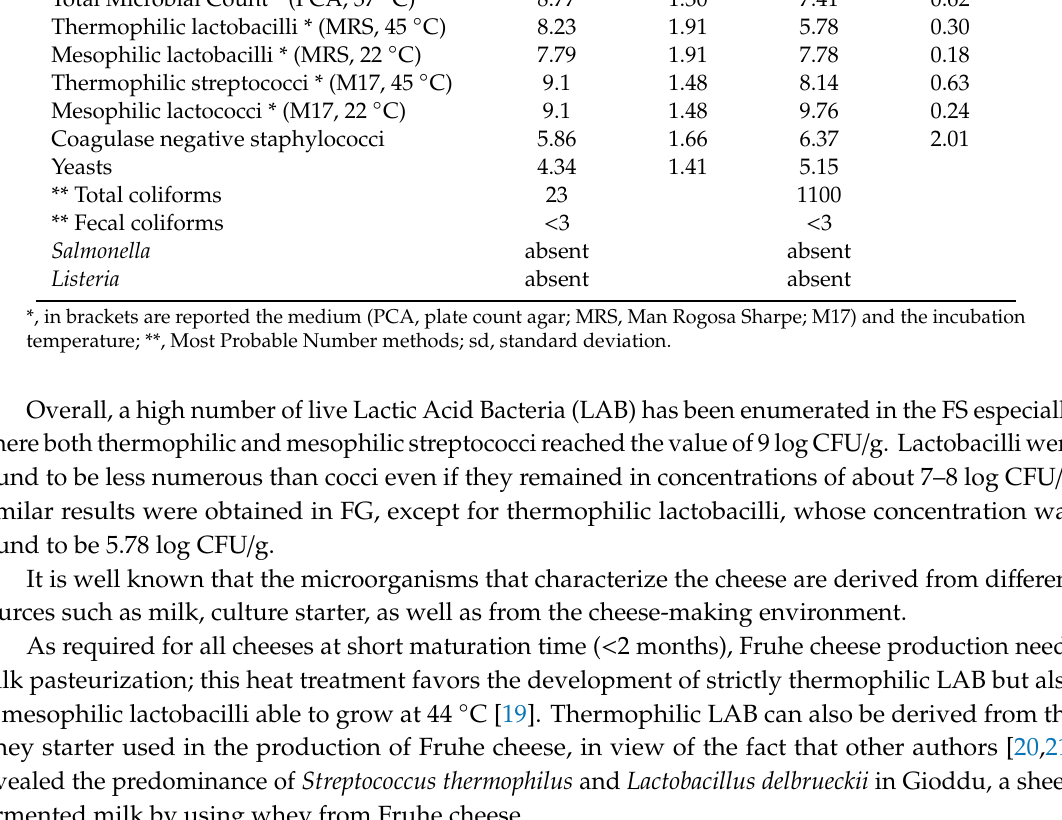
Table 2. Microbial counts of Fruhe cheese produced with sheep (FS) and goat milk (FG). Microbial Groups FS FG log CFU / g sd log CFU / g sd Total Microbial Count * (PCA, 37 ◦ C) 8.77 1.30 7.41 0.62 Thermophilic lactobacilli * (MRS, 45 ◦ C) 8.23 1.91 5.78 0.30 Mesophilic lactobacilli * (MRS, 22 ◦ C) 7.79 1.91 7.78 0.18 Thermophilic streptococci * (M17, 45 ◦ C) 9.1 1.48 8.14 0.63 Mesophilic lactococci * (M17, 22 ◦ C) 9.1 1.48 9.76 0.24 Coagulase negative staphylococci 5.86 1.66 6.37 2.01 Yeasts 4.34 1.41 5.15 ** Total coliforms 23 1100 ** Fecal coliforms < 3 < 3 Salmonella absent absent Listeria absent